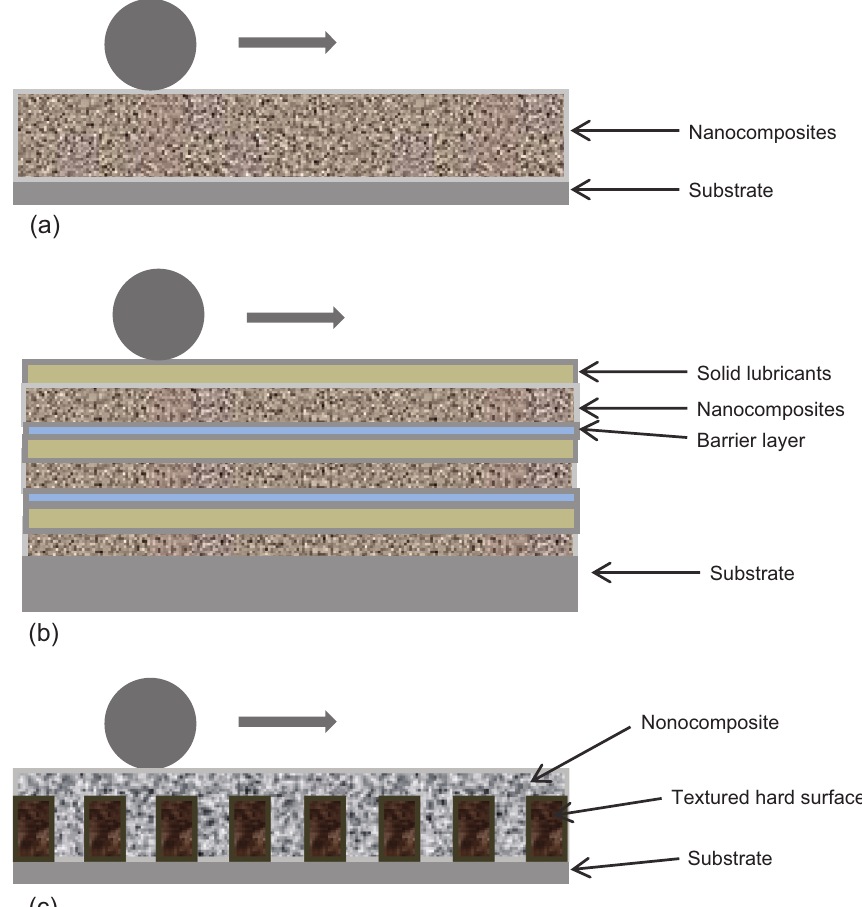
Figure 10. Schematic diagrams of three classes of adaptive coatings: (a) nanocomposites; (b) multi-layer structured coatings; (c) nanocomposite coatings on textured hard